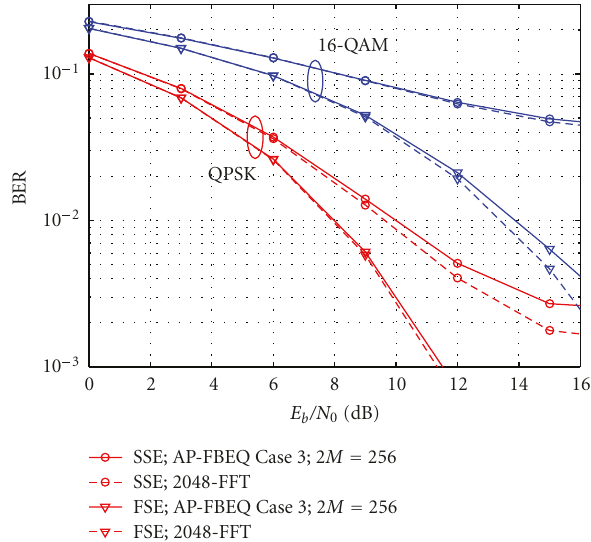
Figure 9: Uncoded BER performance comparison between SSE and FSE-type FB-FDE and FFT-FDE with QPSK and 16-QAM modu- lations. AP-FBEQ Case 3 equalizer with 2 M = 256 subbands and overlapping factor K = 5 was used.